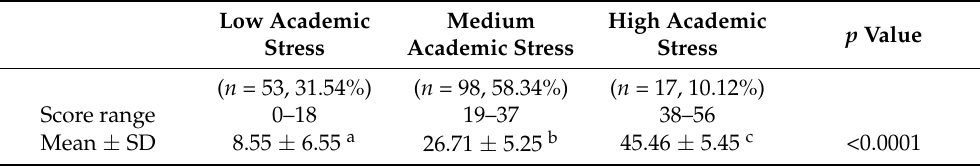
Table 2. Comparison of academic stress score categories in